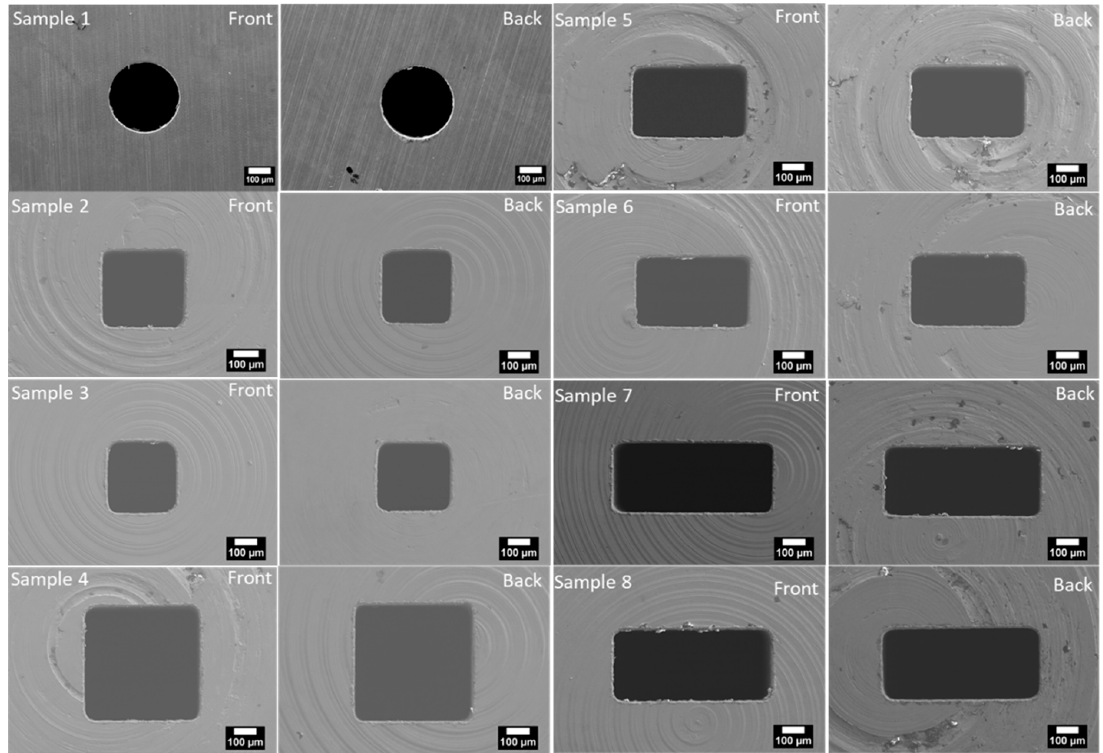
Figure 1. SEM images (front and back) of all the discs containing the micro-orifice.